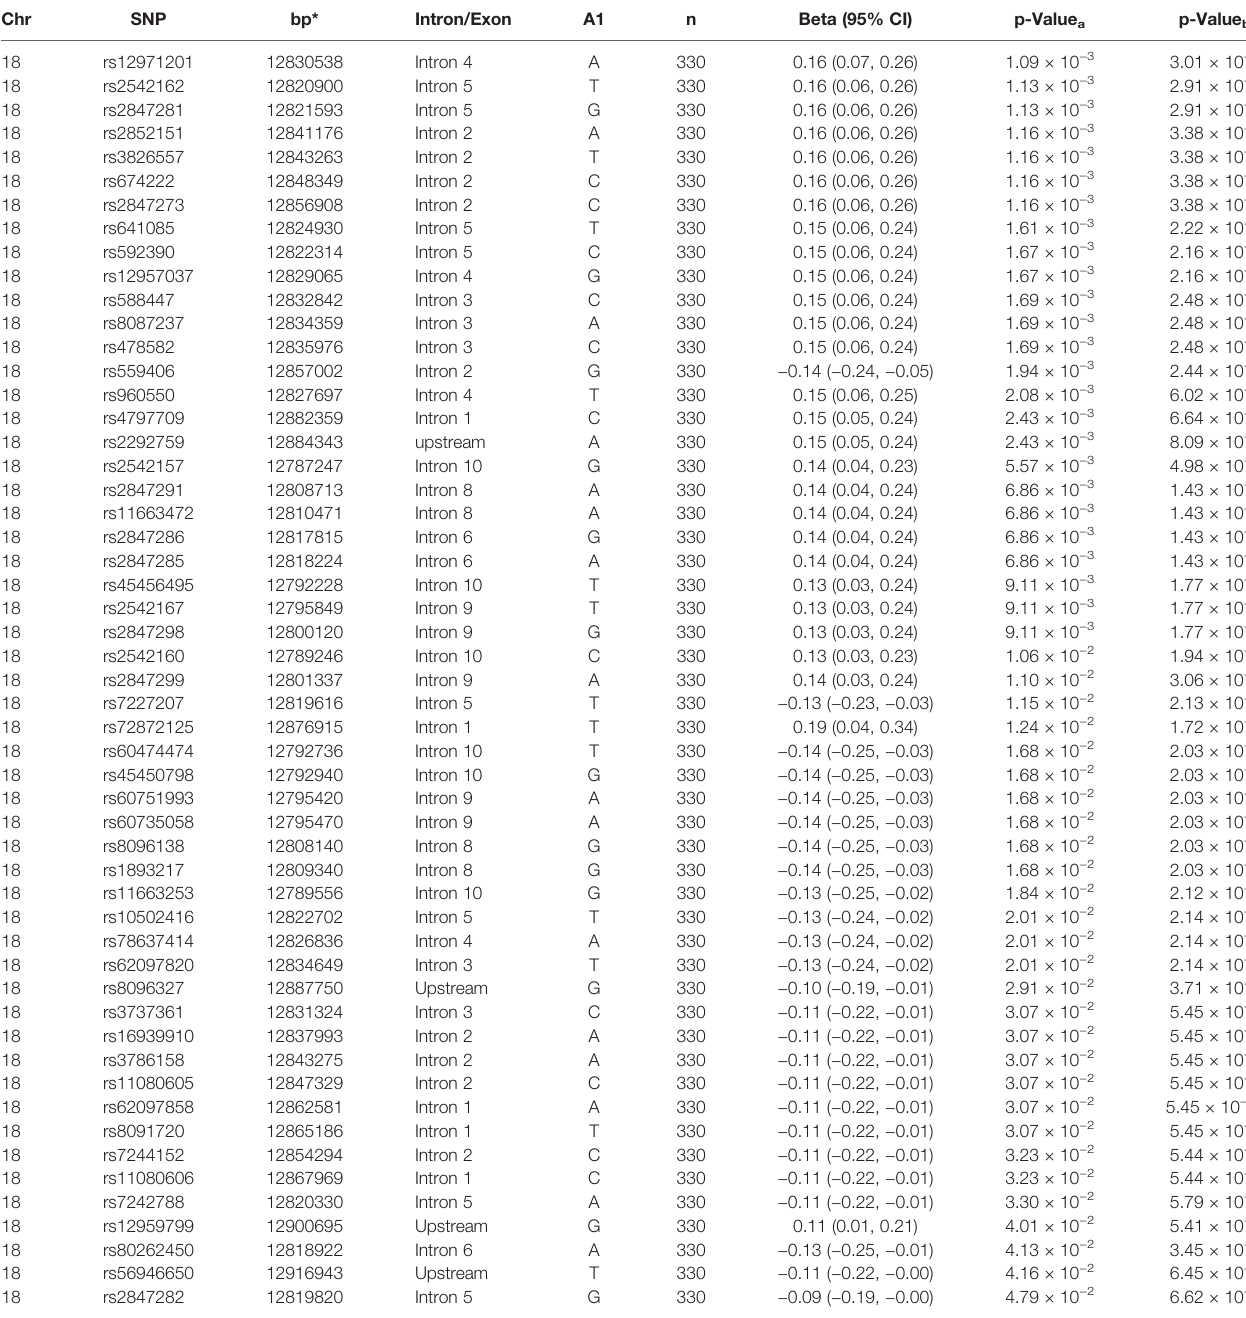
TABLE 4 | Imputed PTPN2 genotypes and their signi fi cant associations with sIL-2R in plasma.